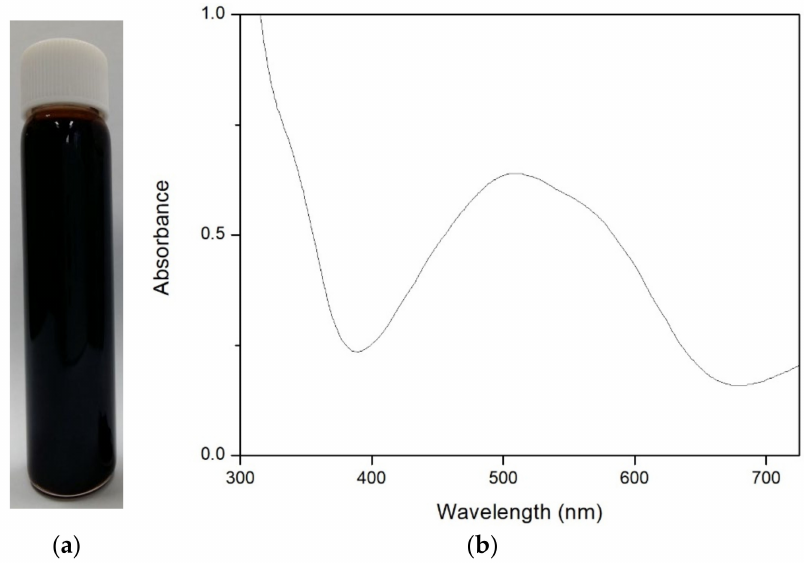
Figure 2. ( a ) Fe(VI) (Na 2 FeO 4 ); ( b ) Adsorption spectrum (UV-Vis) of Fe(VI).